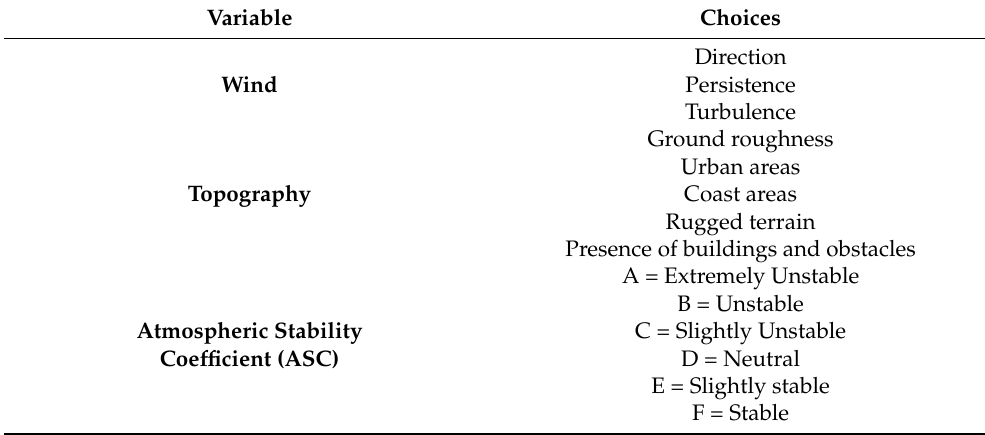
Table 2. Geoenvironmental